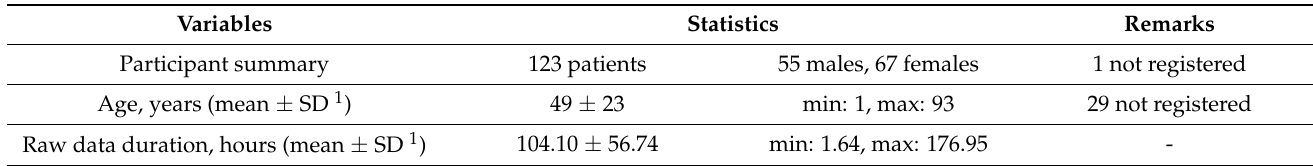
Figure 2. The electrode location for ECG monitoring using the CarePatch™ ECG patch. Table 3. The basic statistics of the samples from the CPPDB.